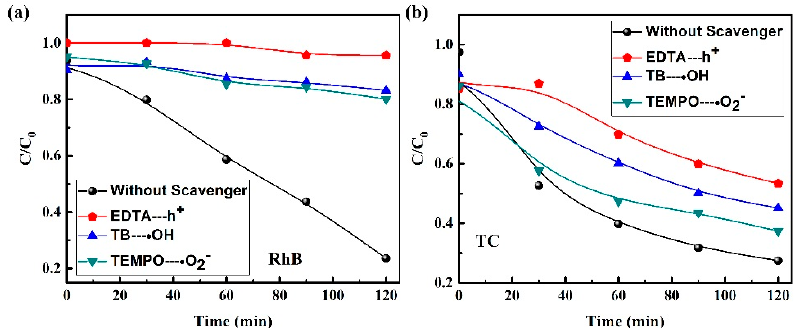
Figure 7. Trapping experiments to identify active species during the photocatalytic degradation of ( a ) RhB solution and ( b ) TC solution.